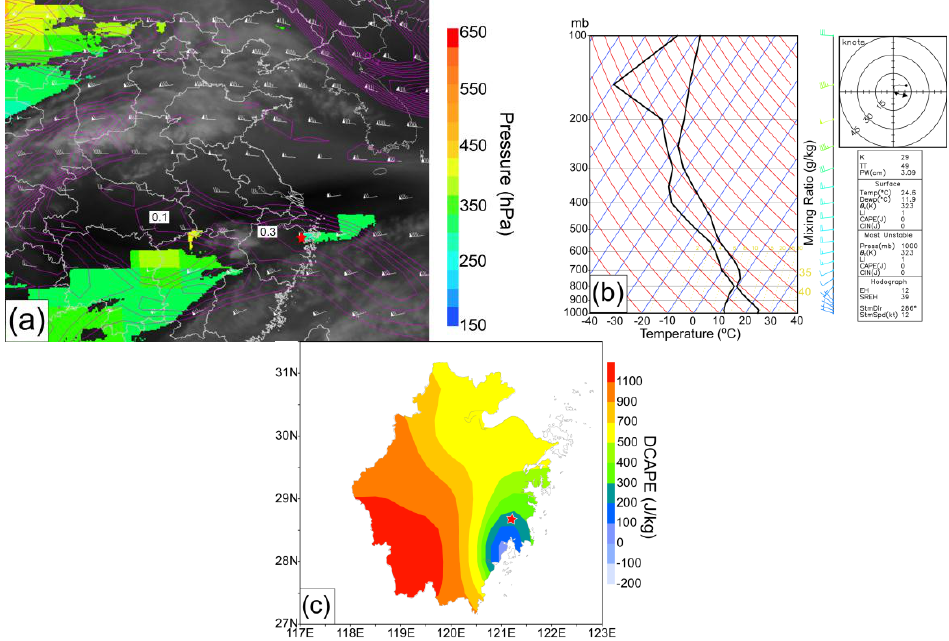
Figure 9. ( a ) The composition map of dry intrusion (shadings) and positive vorticity (contours, unit: 10 −4 s −1 ) at 315K isentropic layer at 16:00LST 18 March 2014. ( b ) skew T log-P diagram at the location shown with starisk in Figure 8a; ( c ) DCAPE distribution within Zhejiang province (The starisk denotes the location of Taizhou city) (Unit: J ∙ kg −1 ).